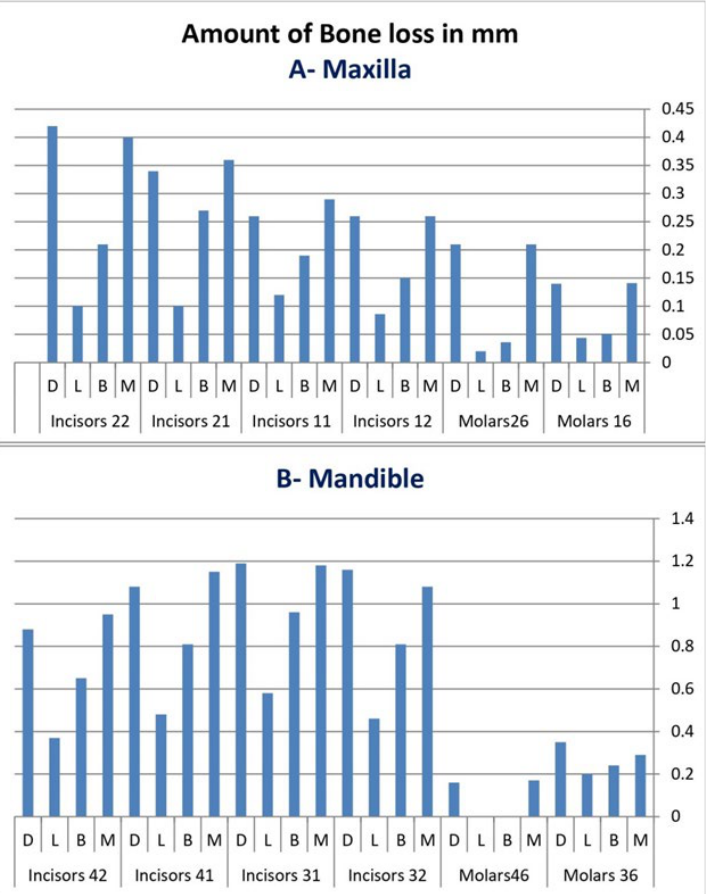
Figure 2. Amount of bone loss in mm at each individual aspect around the maxillary ( A ) and mandibular ( B ) 1st molars and incisors.